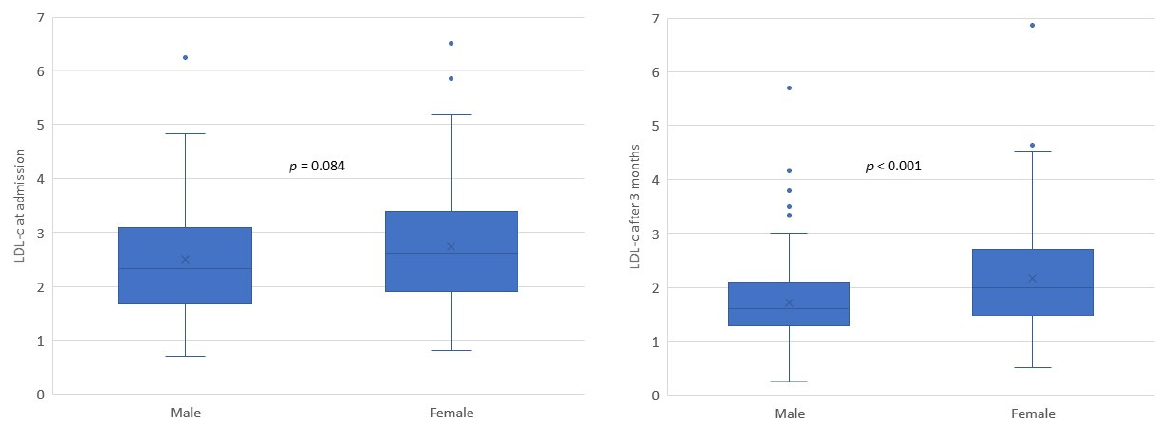
Figure 1. Low-density lipoprotein cholesterol (LDL-C) levels at admission and after 3 months in male and female participants.